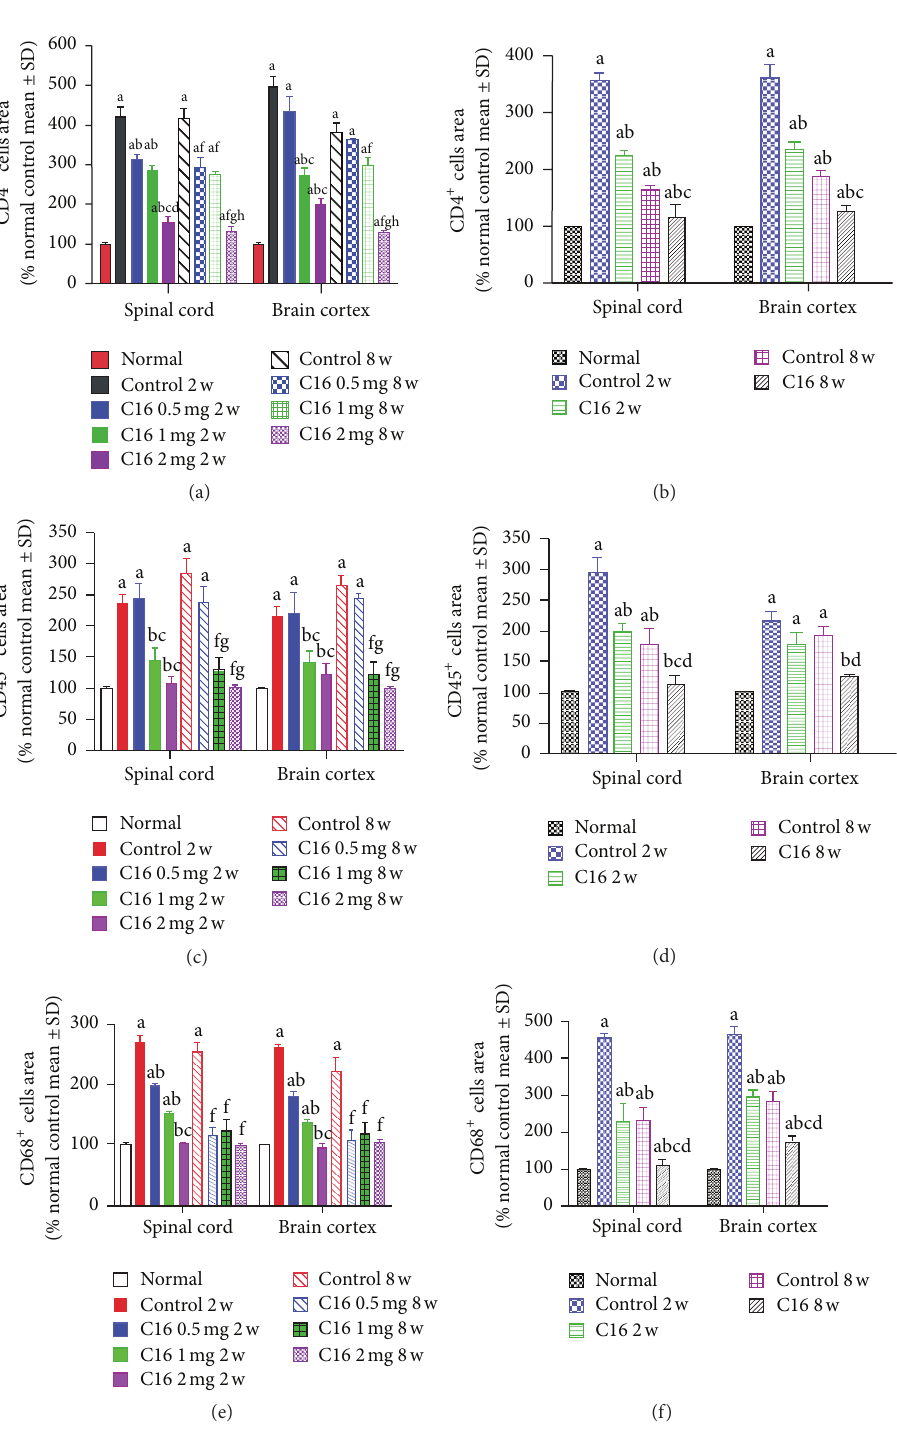
lymphocytes extravasation to a certain extent (b). Medium to high-dose C16 treatment also reduced CD45 + leukocytes infiltration (c). C16 late treatment also inhibited CD45 + leukocytes infiltration to a certain extent (d). Medium to high-dose C16 treatment reduced CD68 +